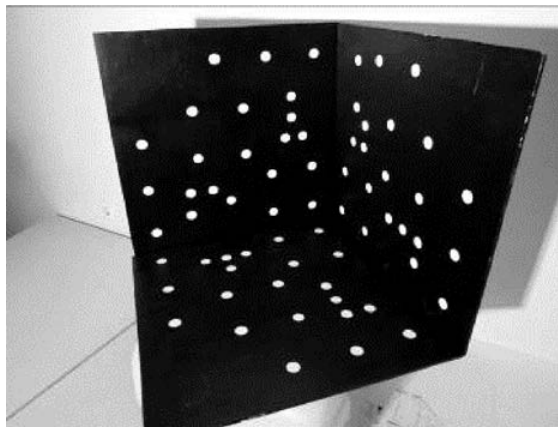
Fig. 1. Test field of camera calibration